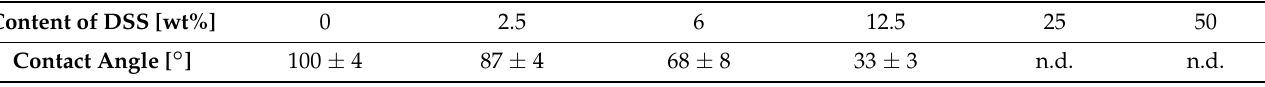
Table 4. Contact angles values of the investigated samples.